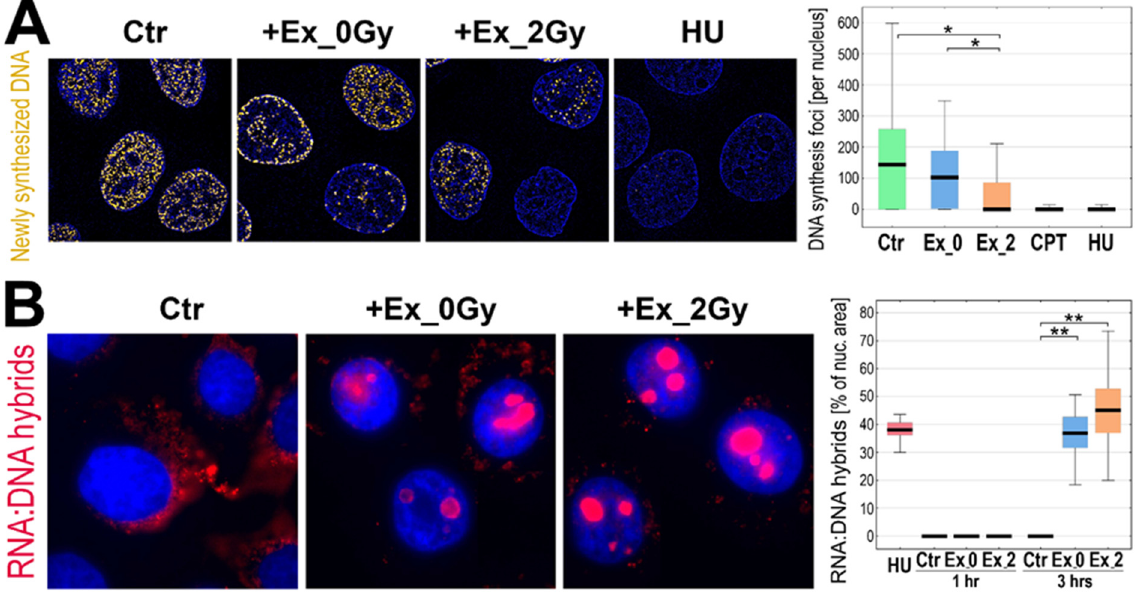
Figure 4. Inhibition of DNA replication by exosomes from irradiated cells. ( A ) Foci of newly replicated DNA initiated in FaDu cells after one-hour of incubation with exosomes released by sham- irradiated (Ex_0Gy) or irradiated (Ex_2Gy) cells or with HU or CPT. ( B ) Visualization of RNA:DNA hybrids in nuclei of FaDu cells incubated for 3 h with Ex_0Gy or Ex_2Gy vesicles; the graph shows the relative occupancy of RNA:DNA hybrids in the nuclei cells incubated with exosomes (1 or 3 h) or HU (1 h). Box plots show the median, minimum, maximum, and lower and upper quartiles; statistically significant differences between groups are represented by asterisks: * p < 0.05 and ** p < 0.001 (only differences between Ctr and exosome-stimulated cells are shown for clarity).